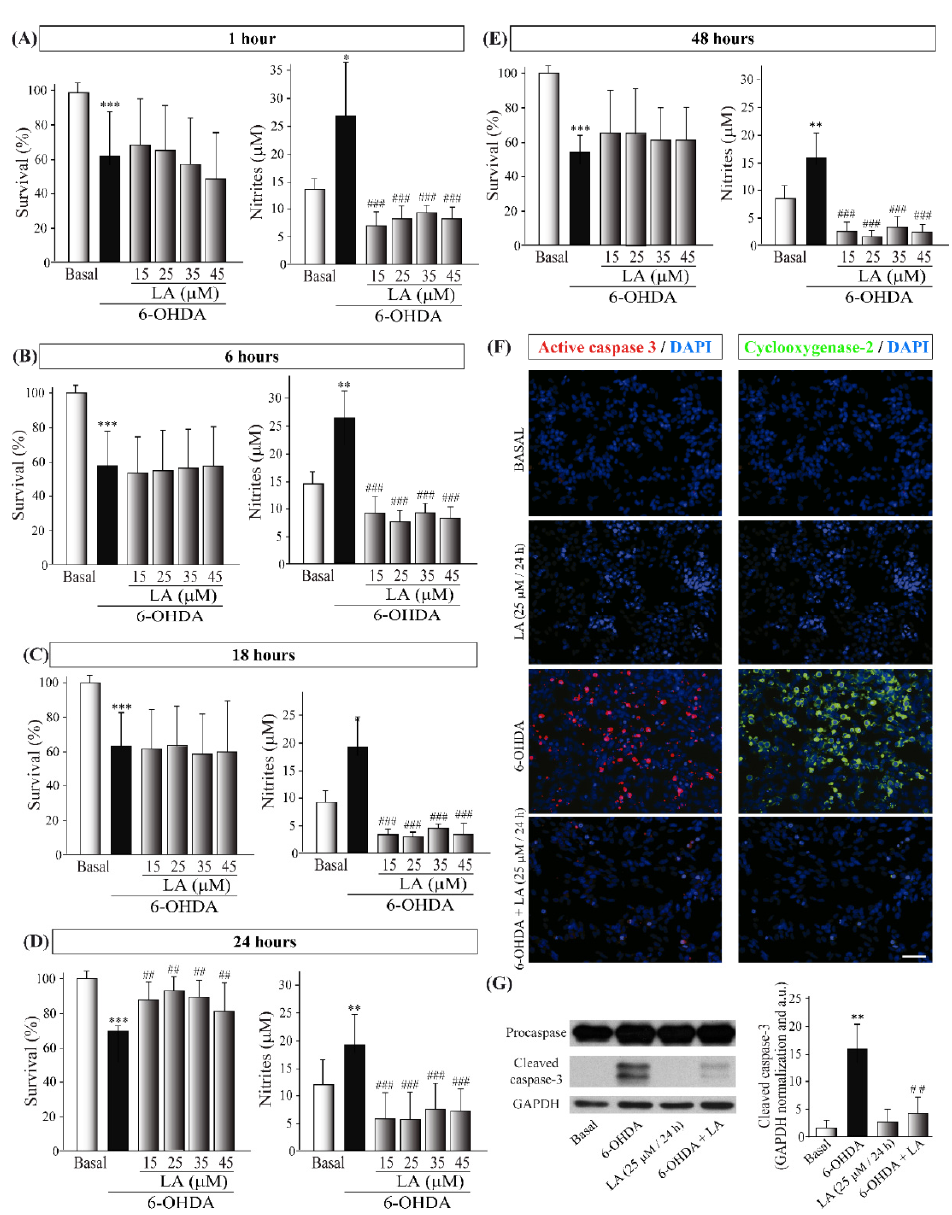
Figure 3. In vitro neuroprotective and anti-inflammatory effects of LA on the SH-SY5Y PD model. The human cell line SH-SY5Y was pre-exposed to different concentrations of LA (15, 25, 35, 45, 55, and 65 μ M) for 1 ( A ), 6 ( B ), 18 ( C ), 24 ( D ), or 48 h ( E ) before incubation with 35 μ M 6-OHDA for 18 h. The cell viability was measured by MTT assay, and determination of the nitrite concentration was evaluated by Griess reaction. Each bar represents the mean ± SD of three independent experiments with 6 replicates per experimental group. Data were analyzed using one-way analysis of variance (ANOVA) followed by the Games–Howell correction in some cases and the Kruskal–Wallis test followed by Dunn’s multiple comparisons test in other cases. *** p < 0.001, ** p < 0.01, * p < 0.05 versus control group; ##: p < 0.01 and ###: p < 0.001 versus 6-OHDA-treated cultures. ( F ) Immunofluorescence images (epifluorescence microscope) of the apoptotic protein active caspase-3 (red) and the proinflammatory factor cyclooxygenase-2 (COX-2, green). Dapi was used as a nuclear marker. Representative results of three independent experiments are shown. Calibration bar: 100 μ m. ( G ) Representative Western blot and quantification showing the expression of cleaved caspase- 3 normalized by GAPDH. Data are the results of three independent experiments, and the error bars correspond to ± SD. Data were analyzed using a one-way analysis of variance (ANOVA) followed